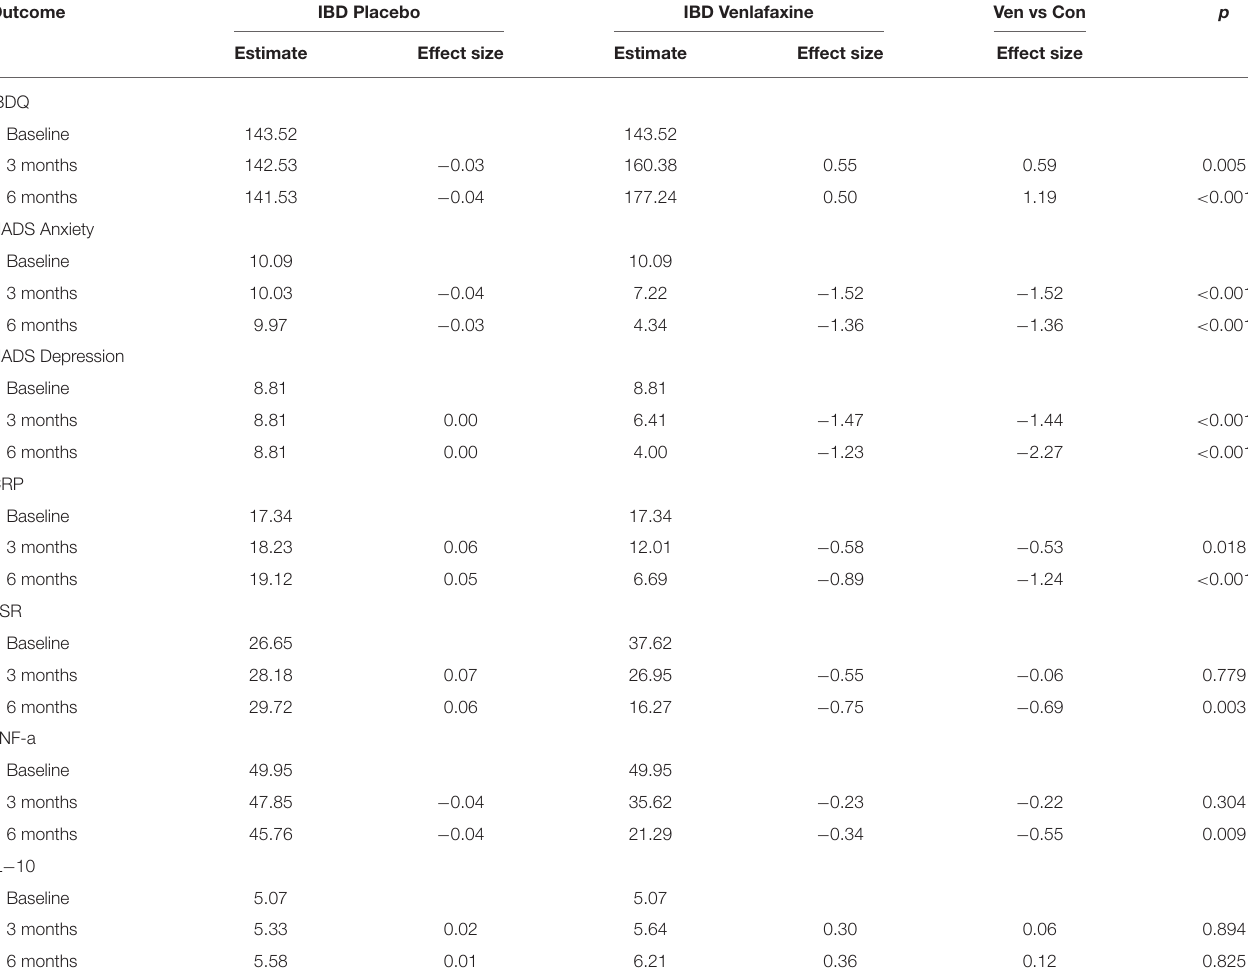
TABLE 2 | Estimates and effects sizes for venlafaxine group and placebo group in IBD population. Outcome IBD Placebo IBD Venlafaxine Ven vs Con p Estimate Effect size Estimate Effect size Effect size